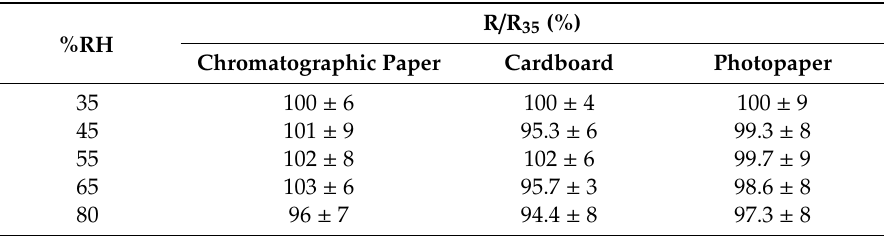
Table 3. Samples resistance behavior in a damp